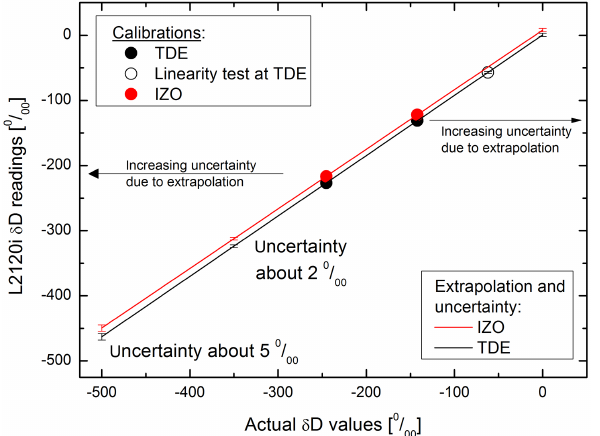
Figure A4. Schematic graph showing the use of two isotope working standards S1 and S2 with known δ D VSMOW . When the two standards are measured by an instrument one obtains δ D measured . A linear regression of the form y = a + bx can be used to transfer δ D measured onto the VSMOW scale. Note that uncertainties in x and y are